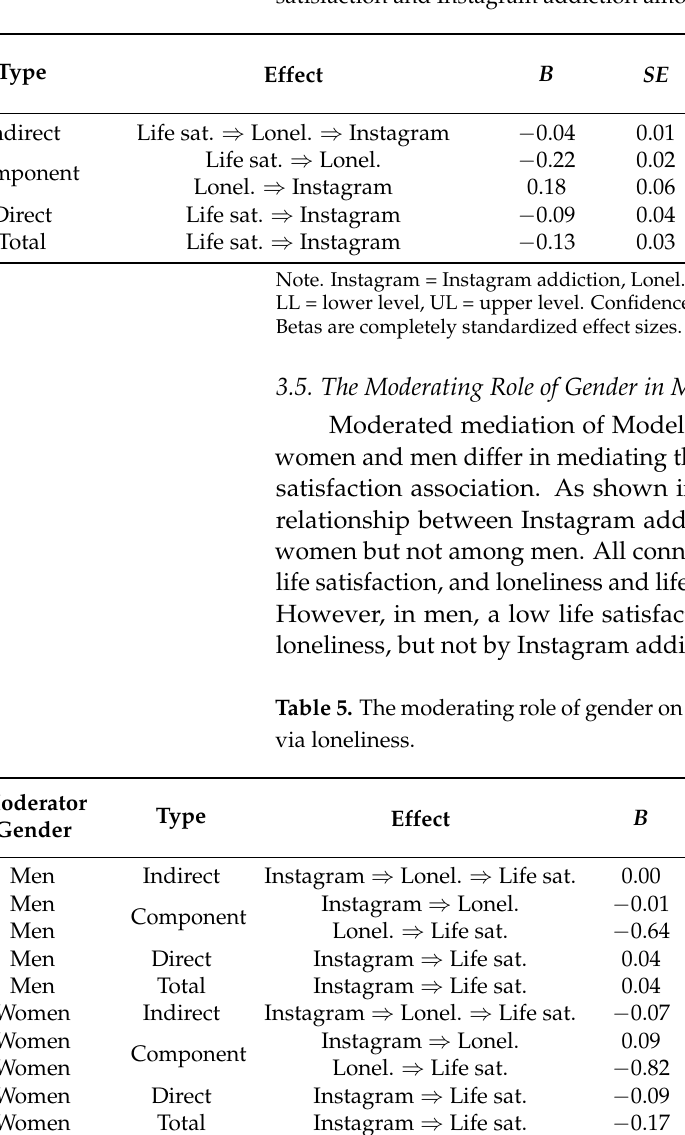
Table 4. Path model for the simple mediating effect of loneliness on the relationship between life satisfaction and Instagram addiction among university students ( N = 954).